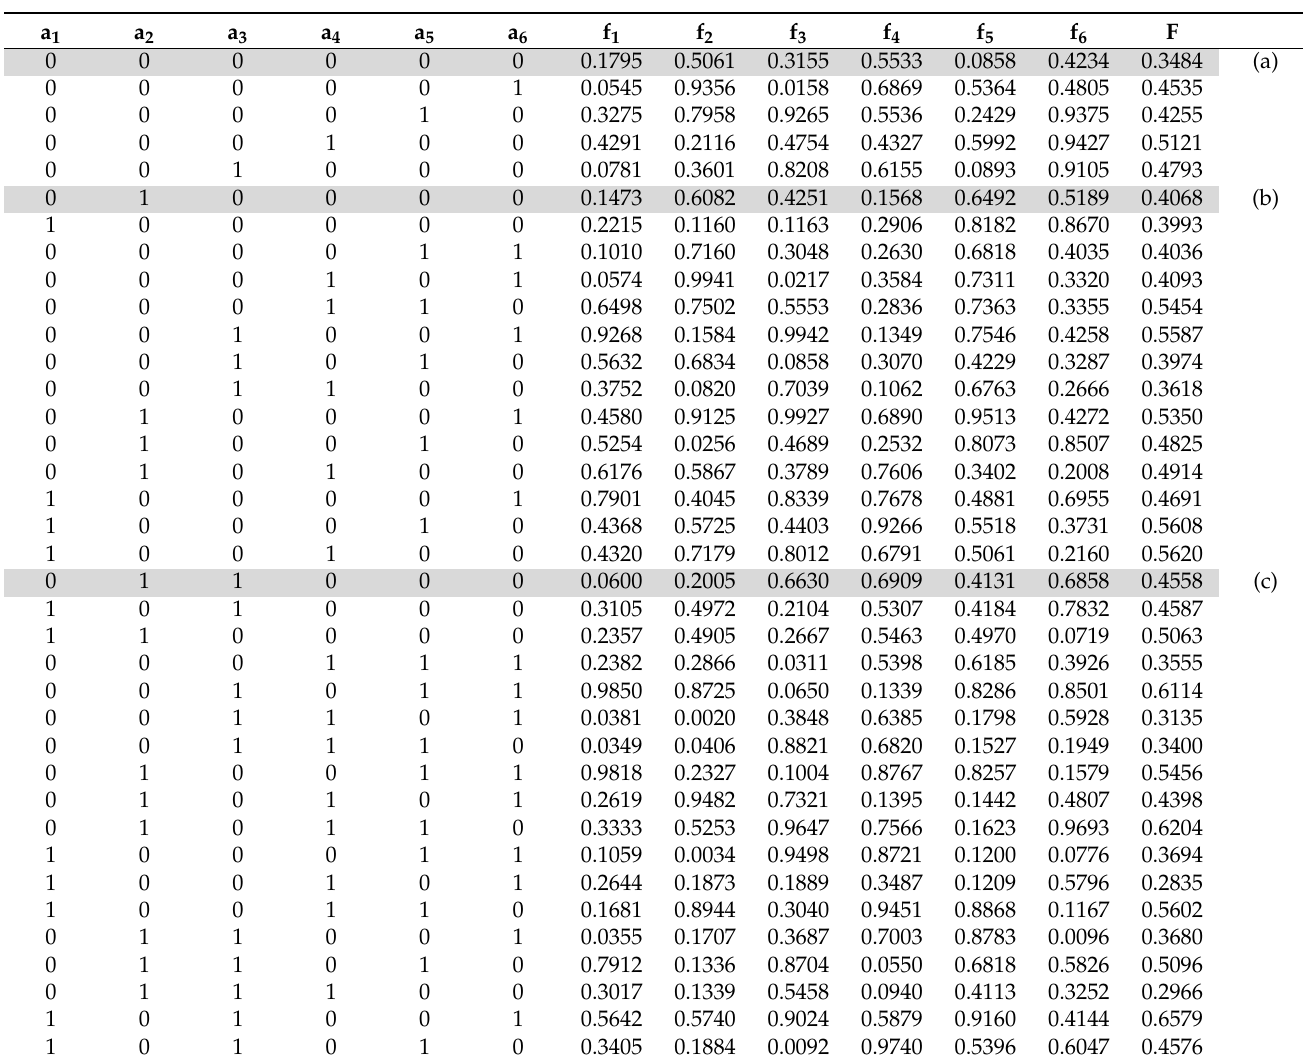
Table 10. System fitness value changes in different